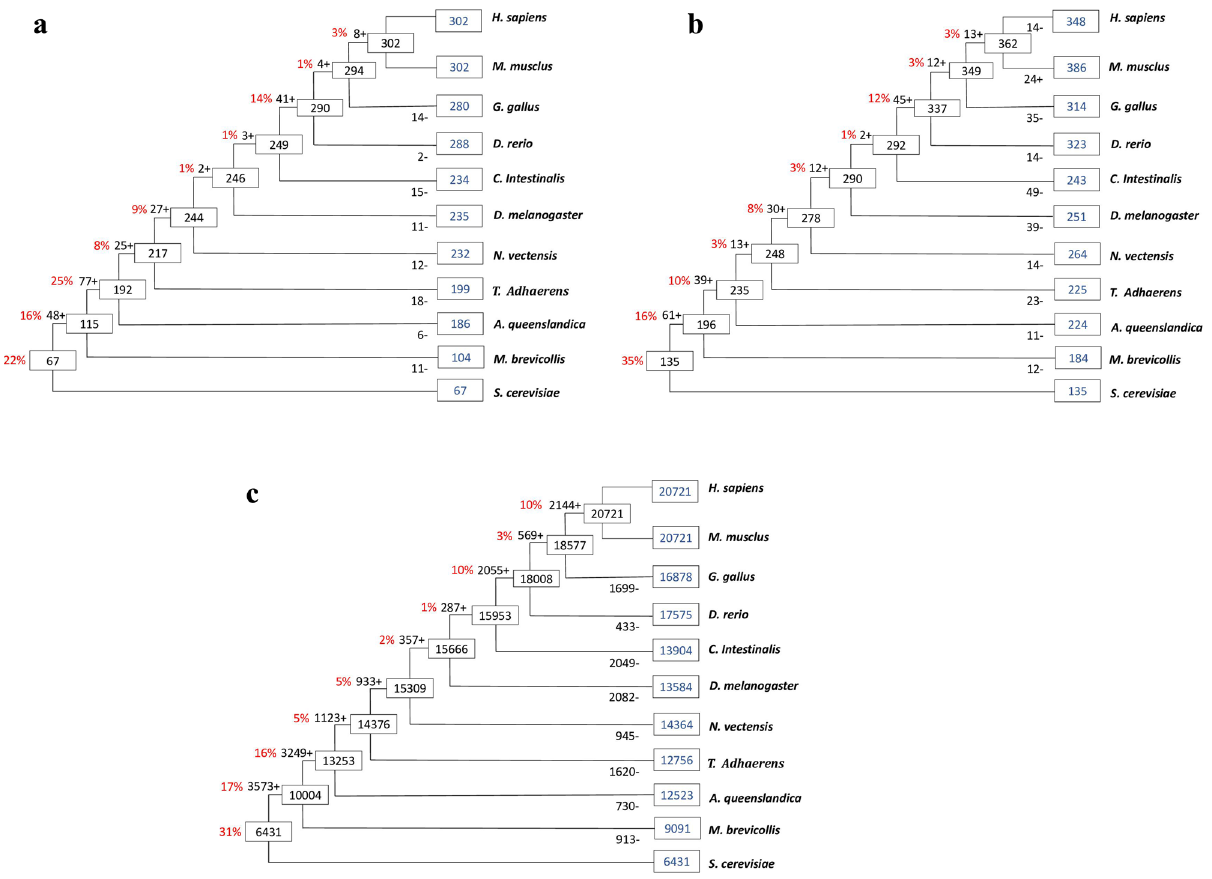
Figure 2. The emergence of the memory ( a ), LMNP ( b ), and reference ( c ) genes during evolution. This schematic tree exhibits gene gain and gene loss events. The blue color represents the number of orthologous genes. Boxes on nodes and numbers on branches show the number of genes present in an ancestor species and gene gains/losses, respectively. Positive marks (+) indicate gene gain, and negative marks (−) display gene loss. The percentage in red color reveals the gene gained during the